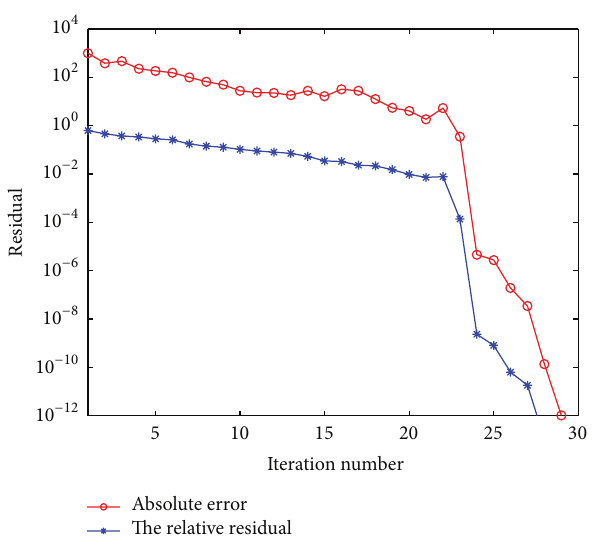
Figure 2: The relative error of solution and the residual for Example